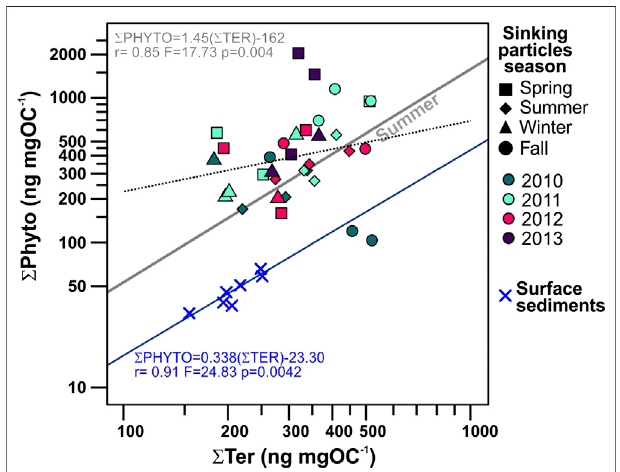
FIGURE 8| Biplot ofPOC-normalized concentrationsof phytoplankton- derived lipid biomarkers ( Ʃ Phyto) vs. terrestrial ( Ʃ Ter) of sinking particles collectedinthedeepIerapetraBasinfromJune2010 – June2013,andsurface sediments collected from January 2007 to June 2012 in the NW LevantineBasin(Pedrosa-Pàmiesetal.,2015).Symbolshapescorrespondto season of the sinking particles and colors correspond to sampling year. Regressionlinesforall(dashedblackline,notsigni fi cative)andsummerperiod (gray line) sinking particles, as well as for surface sediments (blue line) are